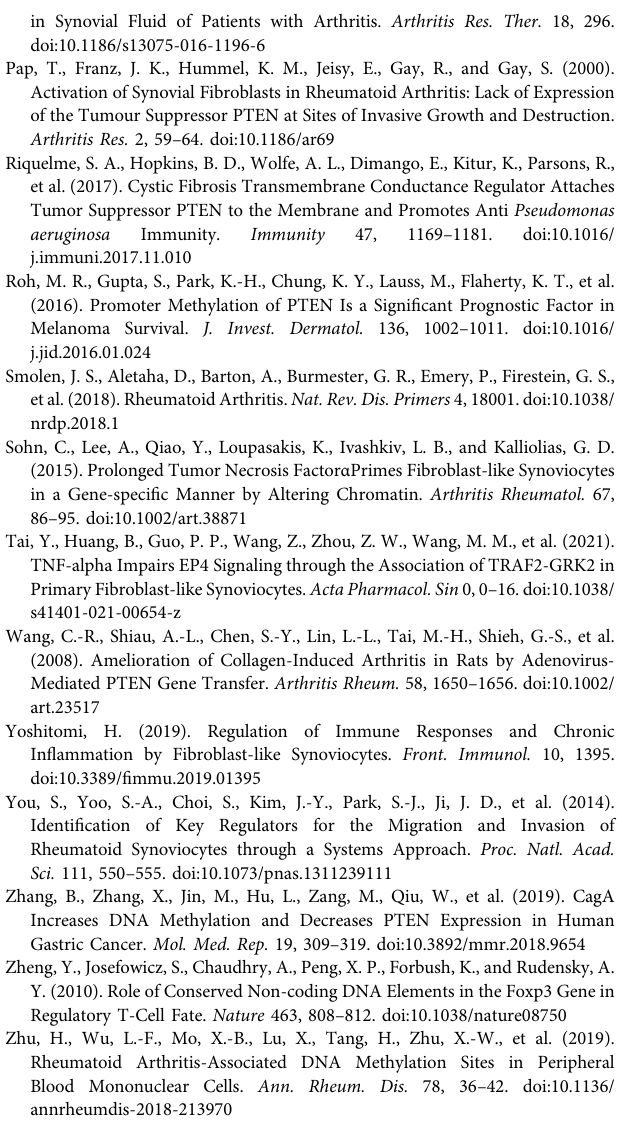
protein (D) levels in synovial tissue analyzed by qRT-PCR and western blotting, respectively. (E, F) IL-1 β , IL-6, IL-17A, TNF- α , and PTEN mRNA (E) and protein (F) levels in synovial tissue analyzed by qRT-PCR and western blotting, respectively. Values represent mean ± SD. ## P < 0.01 vs. normal group; *P < 0.05, **P < 0.01 vs. AIA